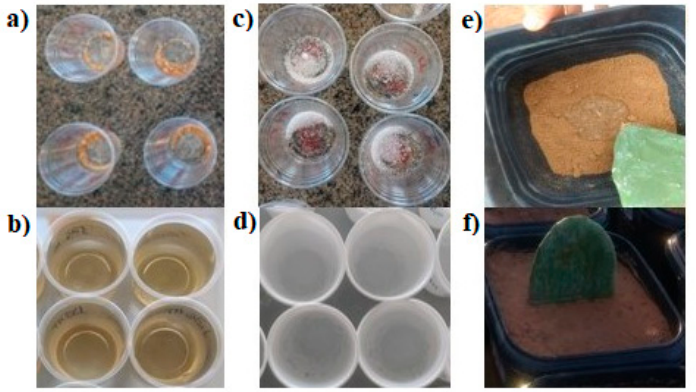
Figure 1. ( a ) Test hydrogel (TH); ( b ) TH hydrated; ( c ): commercial hydrogel (CH); ( d ) CH hydrated; ( e ) application of hydrogels to the soil before planting; ( f ) cactus pear planted with hydrogels.